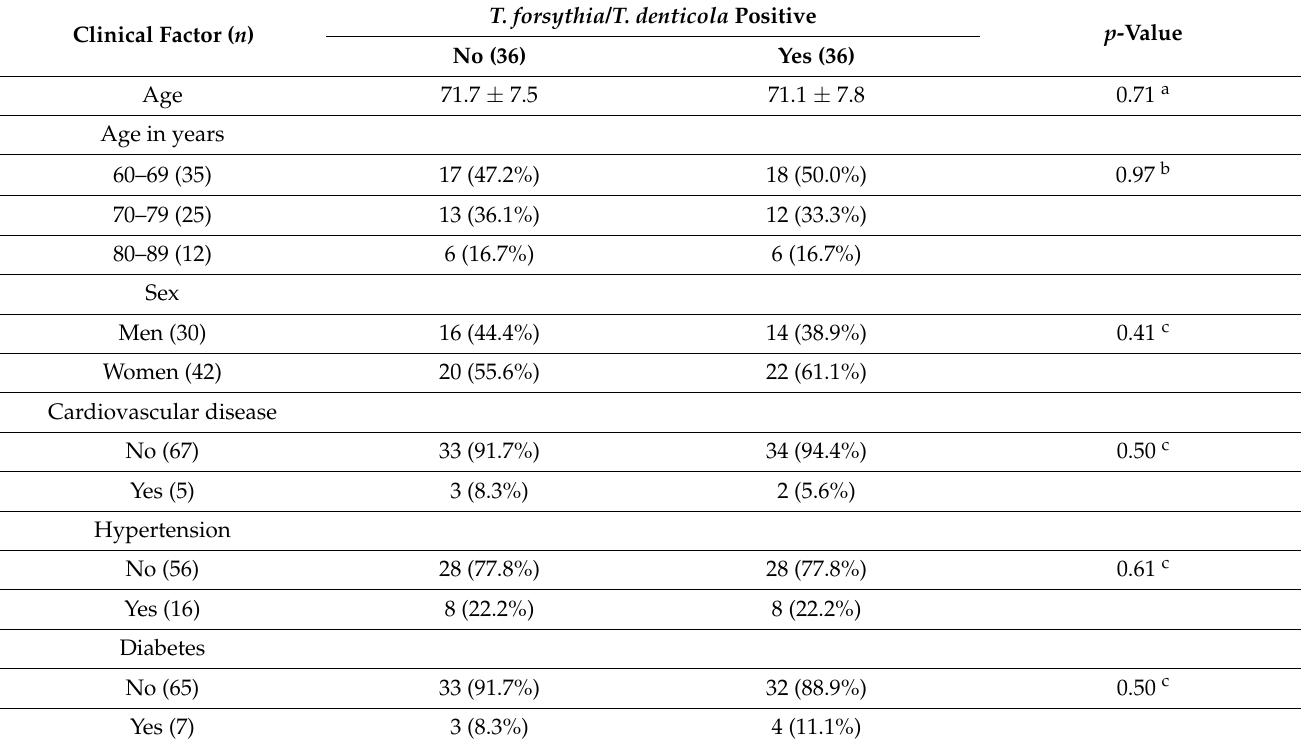
Table 5. Associations of T. forsythia / T. denticola presence with PISA and PESA in 72 propensity score-matched patients. T. forsythia / T. denticola Clinical Factor ( n )